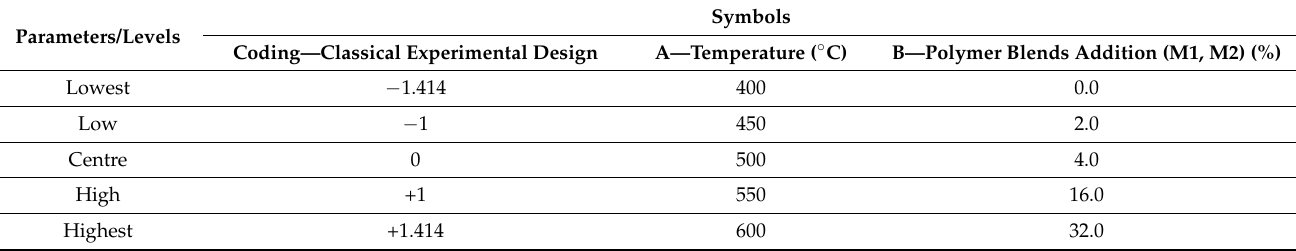
Table 3. Physical and coded values of parameters for the design of experiments [37], reproduced with permission from